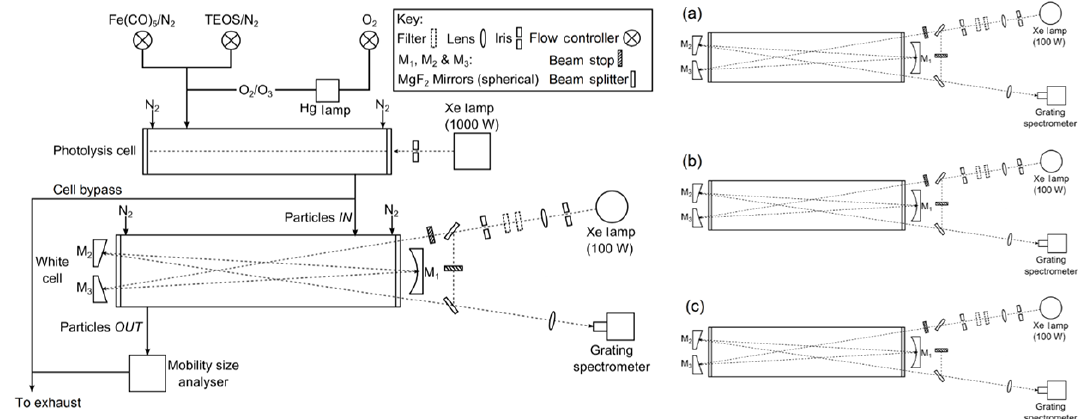
Figure 1. Schematic diagram of the experimental system used for the generation and optical detection of MSP analogues, where (a) , (b) and (c) show different beam configurations used to generate a normalized cell